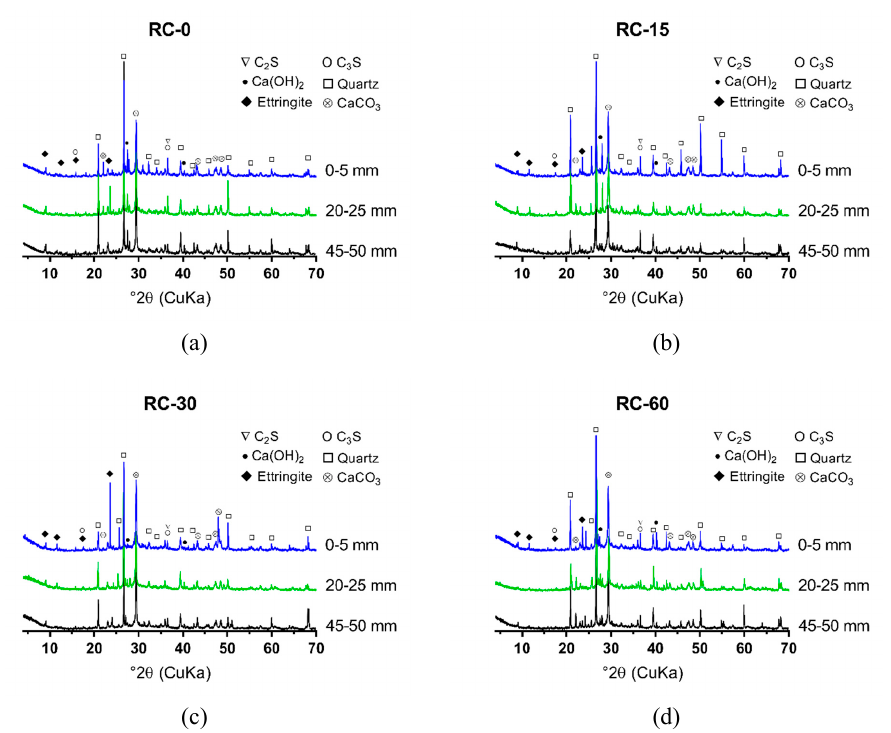
Figure 7. XRD spectrum of the powder samples from aggregate concretes (RC), after 0, 15, 30, and 60 cycles of sulfate attack (sample location distance to the attack surface: 0–5 mm, 20–25 mm, and 45–50 mm): ( a ) RC-0; ( b ) RC-15; ( c ) RC-30; ( d ) RC-60.